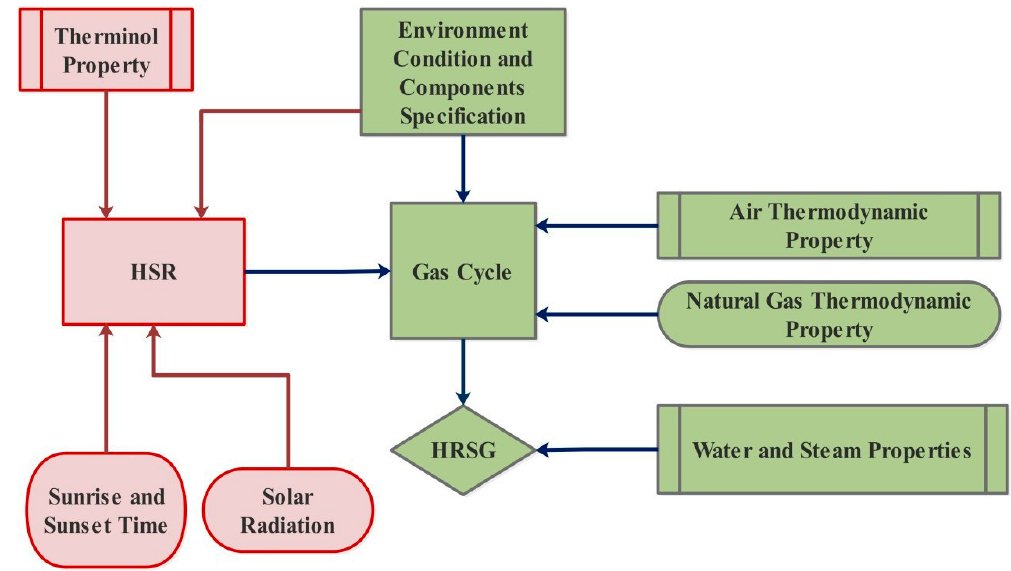
Figure 2. Block diagram of main computer program and different subroutines connections.